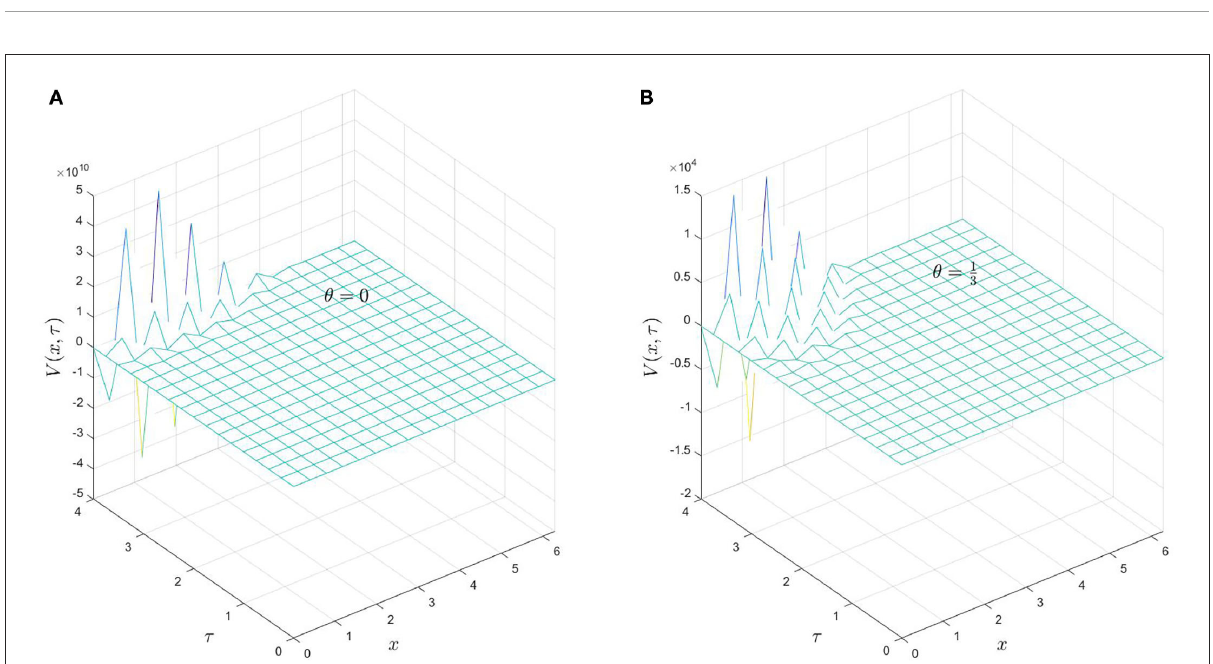
FIGURE4 (A,B) The behavior of V ( x , τ ) of Example 1 when the stability condition (Equation 29) is broken for θ